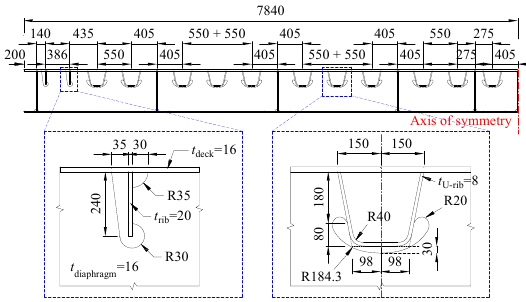
Figure 7. Geometric sizes of the model (unit: mm).